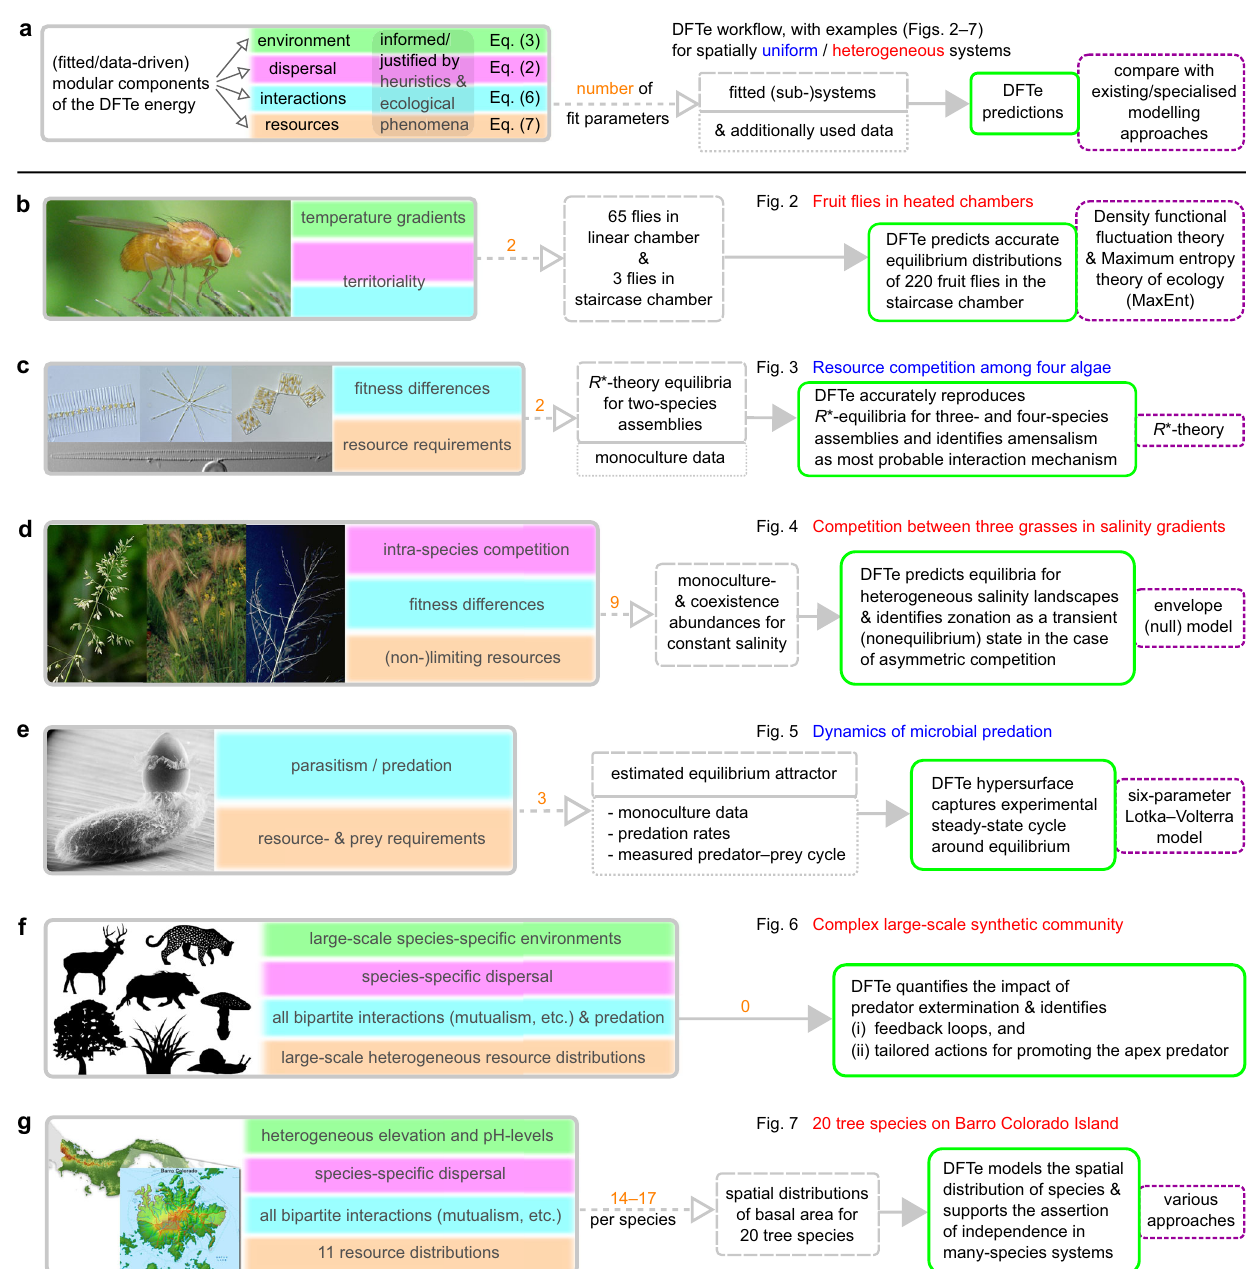
heterogeneous elevation and pH-levels